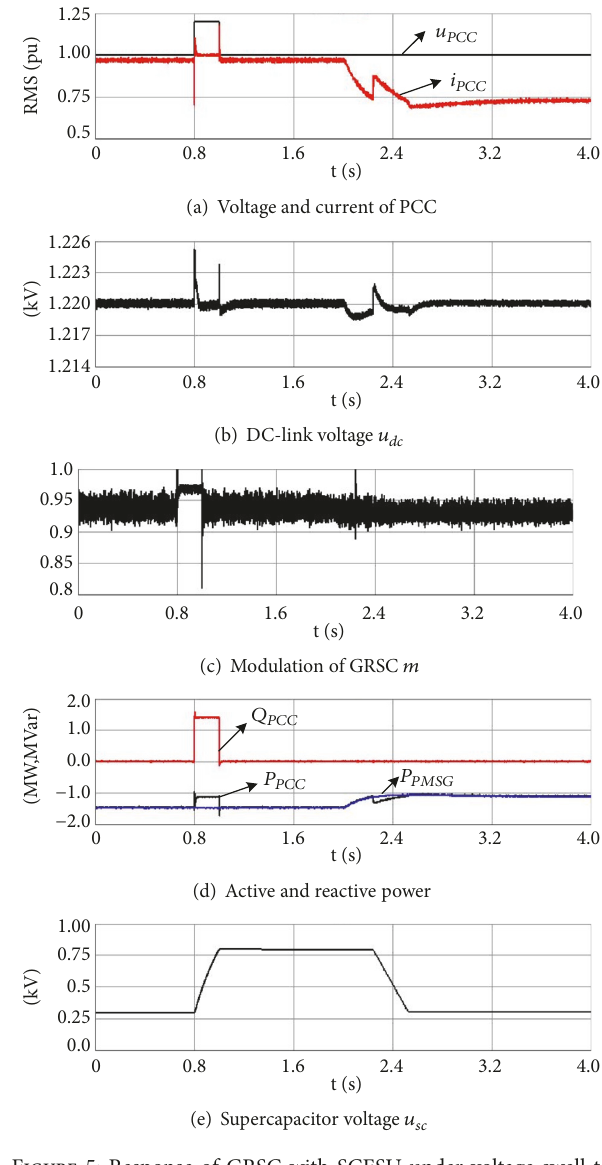
Figure 5: Response of GRSC with SCESU under voltage swell to